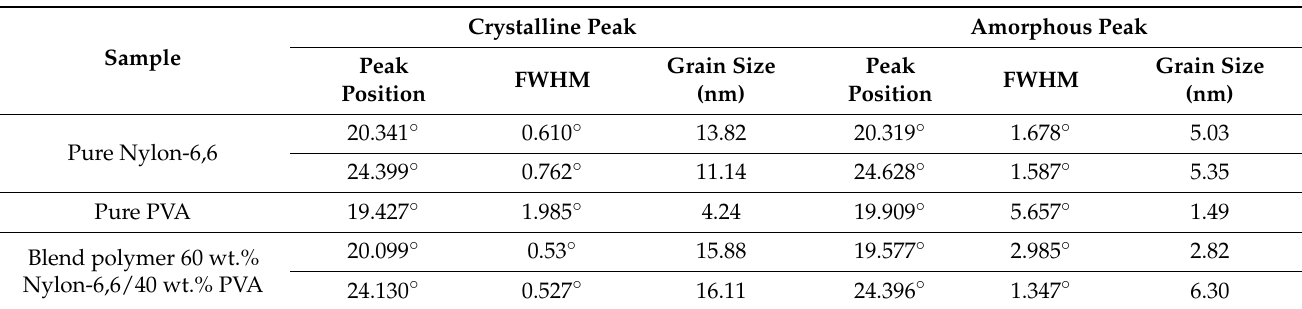
Table 2. The peak position, FWHM, and grain size for the crystalline and amorphous peaks for